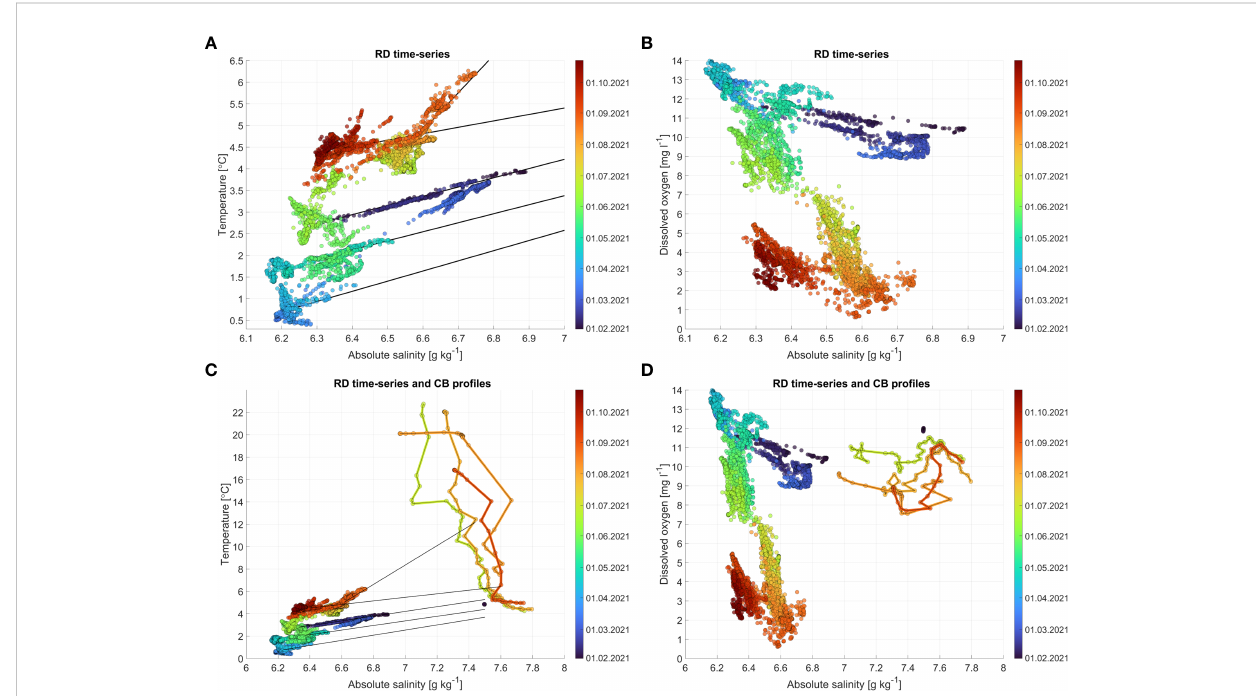
FIGURE 4 Ruhnu Deep time-series (A – D) with CB pro fi les (C, D) in temperature-salinity (A, C) and salinity-oxygen diagrams (B, D) . CB pro fi le data points are connected with